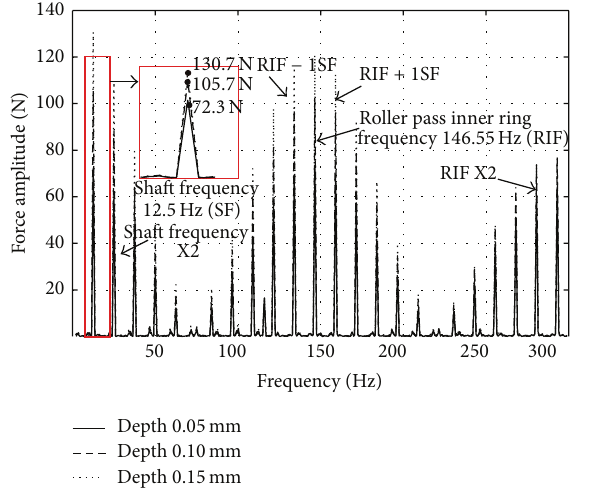
Figure 14: Defect depth: force spectrum for defect on inner raceway in vertical direction.